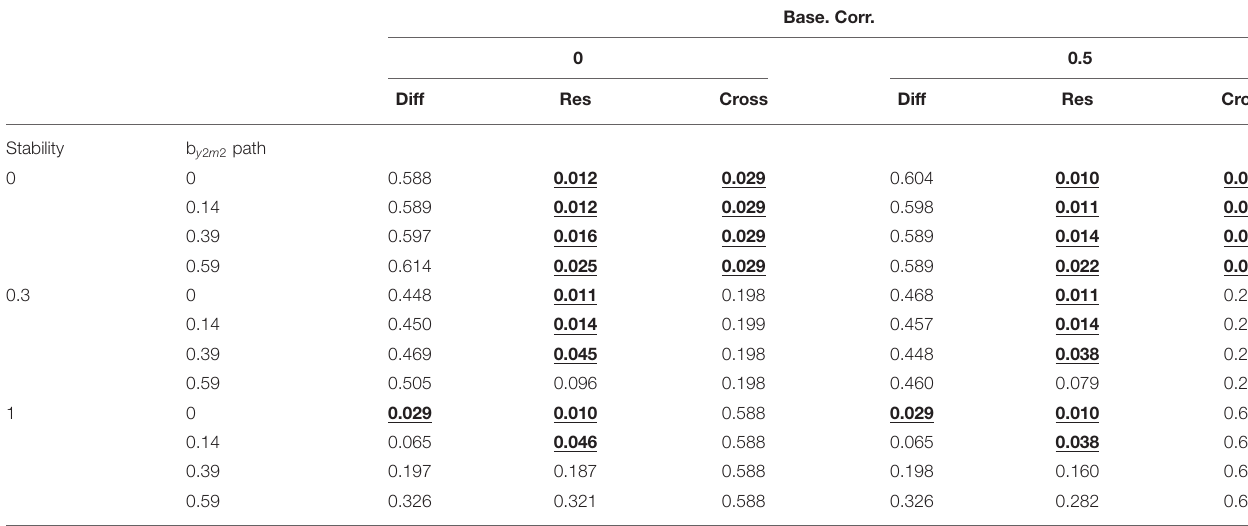
TABLE 3 | RMSEA values for the difference score model (Diff), residualized change score model (Res), and cross-sectional model (Cross) for M 2 cross-lag = 0 and Y 2 cross-lag = 0.